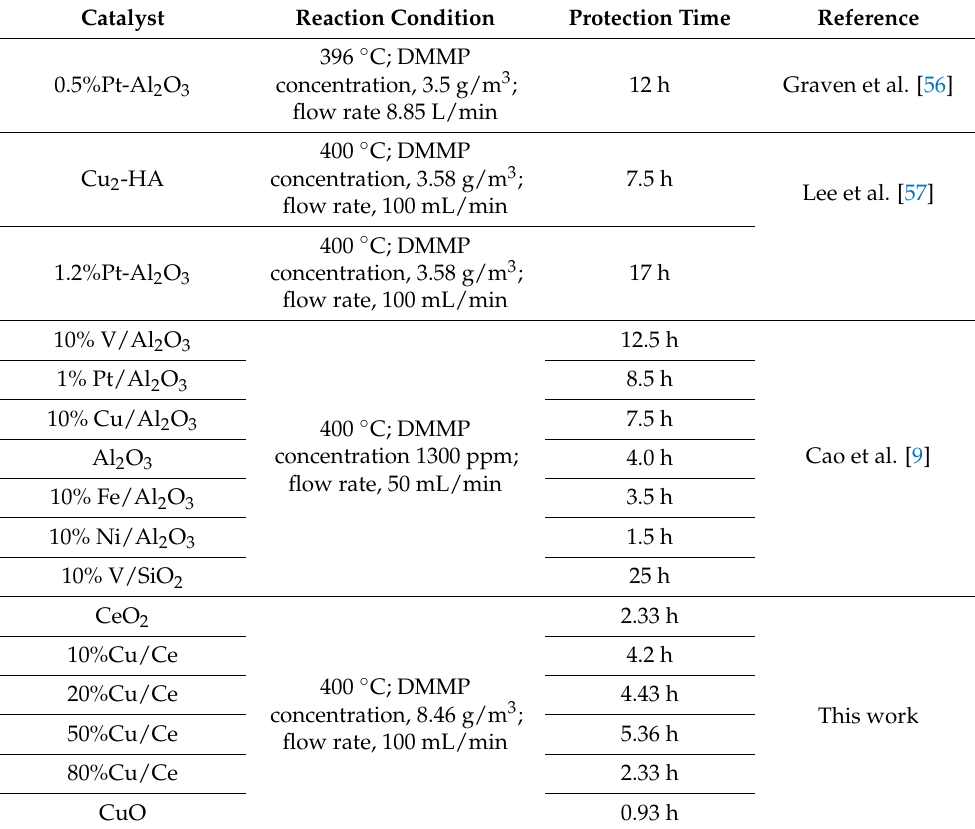
Table 5. A comparison of protection time on various